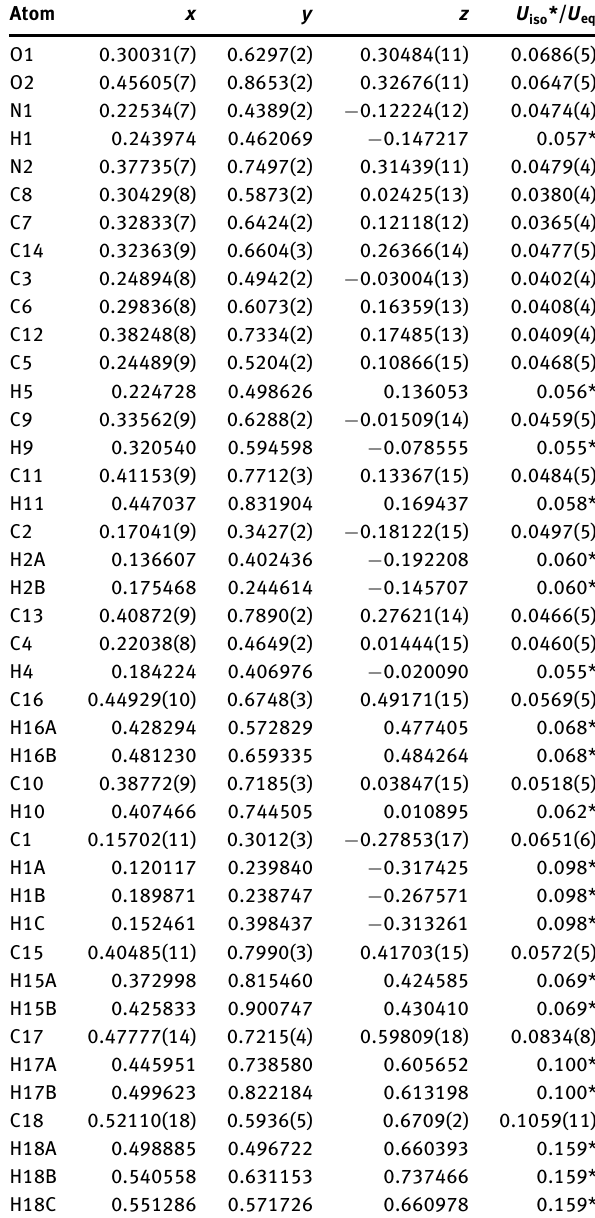
Table 2: Fractional atomic coordinates and isotropic or equivalent isotropic displacement parameters (Å 2